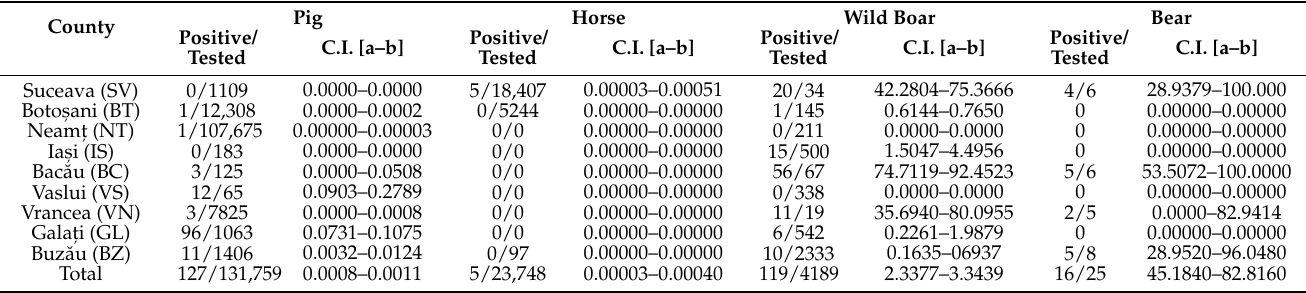
Table 3. Geographical prevalence of T. spiralis in pigs, horses, wild boars and bears, in North- Eastern